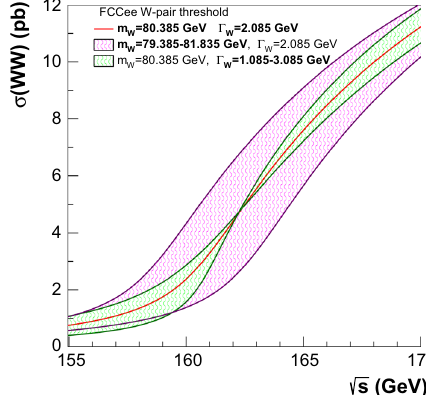
Fig. 3.2 ProductioncrosssectionofWboson(left)andtop-quarkpairs (right) in the vicinity of the production thresholds, with different values of the masses and widths. In the left panel, the pink and green bands include variations of the W mass and width by ± 1 GeV. In the right